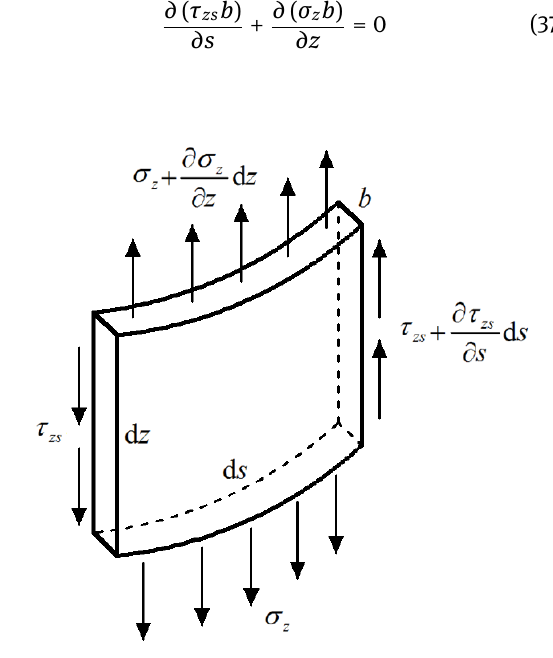
Figure 6: Longitudinal equilibrium of an infinitesimal strip of